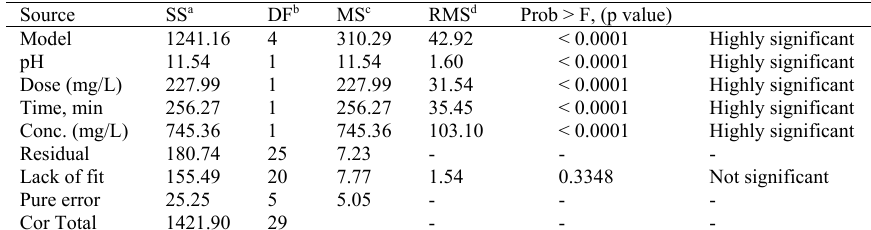
Fig. 1: Schematic design of the catalytic ozonation reactor Table 3: Analysis of variance (ANOVA) results and adequacy of the quadratic models for benzene removal (COP/CuO-NPs) by catalytic ozonation process